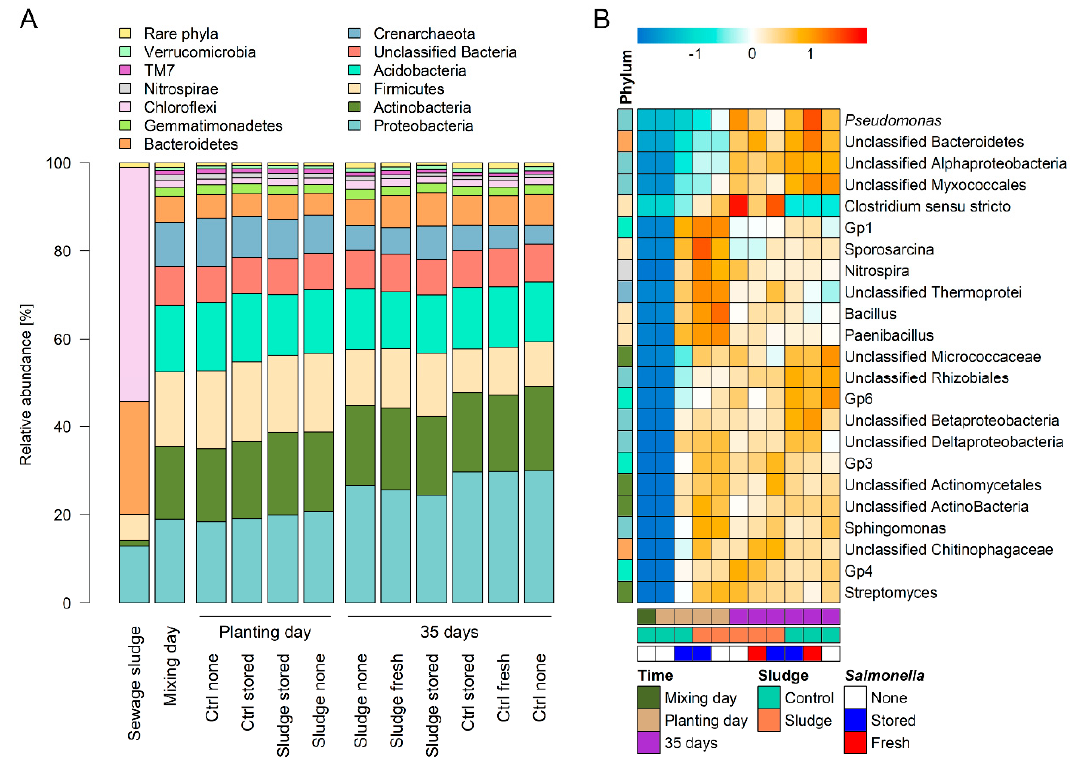
Figure 1. Taxonomic distribution of microbial phyla and treatment responding groups. Diluvial sand soil was treated with composted sewage sludge (CSS) and inoculated with Salmonella enterica serovar Typhimurium strain 14028s ( Salmonella ). Total DNA was sampled after mixing the soil with CSS, directly after planting B. rapa and 35 days after planting. The relative abundance was calculated as percentage of 16S rRNA gene sequences belonging to a particular phylum in each sample and the mean is displayed for each group in a stacked bar plot ( A ). Taxonomic groups, which di ff er in their relative abundance between treatments, were identified using negative binomial regression, generalized linear model fit and a likelihood ratio test post-hoc false discovery rate multiple correction test ( p < 0.05). These groups are represented using a color code (center-scaled mean of read counts out of four replicates) ( B ). For a complete list see Supplementary Table S2. Each experimental variant was represented by at least three replicates.